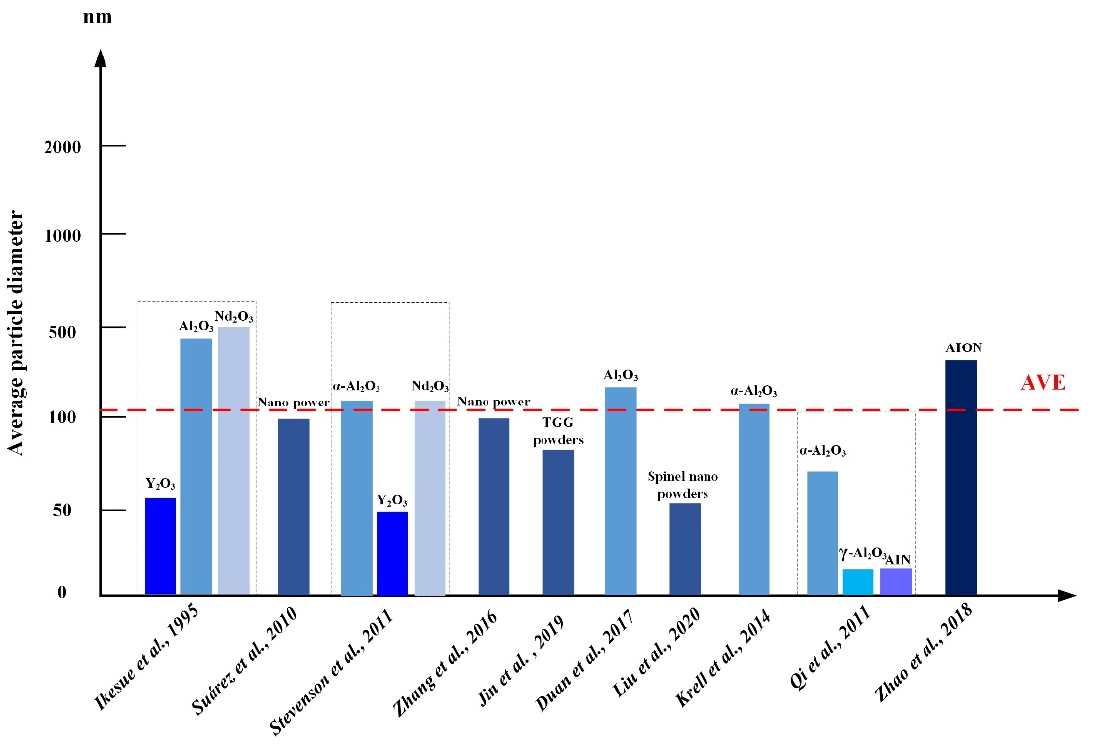
Figure 18. Average diameter of nano powders in the reviewed transparent nano-ceramics [12,14,15,17,43,52,81,83,86,88].